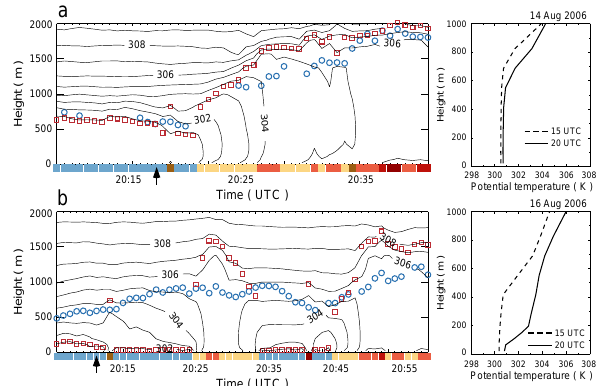
Fig. 15. Cross sections (left panels) and vertical profiles (right pan- els) of the potential temperature simulated by the UCM (shaded periods in Fig. 13) on (a) 14 August and (b) 16 August. Observed (open circle) and simulated (open square) ABL heights are overlaid. Land-use types at the location of aircraft are coded by the same col- ors used in Fig. 2. The vertical profiles of simulated potential tem- perature are plotted for 15:00UTC and 20:00UTC at the aircraft location (near coastal area over the Gulf of Mexico, see Fig. 13) indicated by a black arrow on each